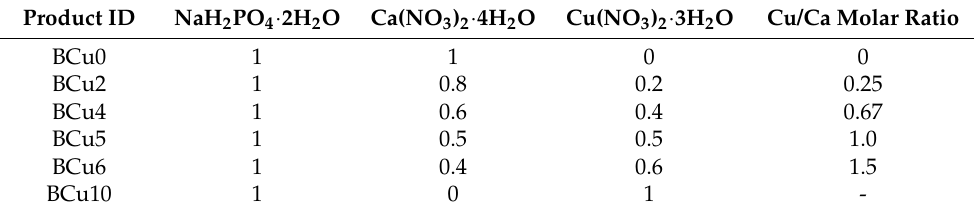
Table 1. Molar proportions of Cu(NO 3 ) 2 · 3H 2 O, Ca(NO 3 ) 2 · 4H 2 O, and NaH 2 PO 4 · 2H 2 O as well as Cu/Ca molar ratios used for the synthesis of calcium–copper phosphate